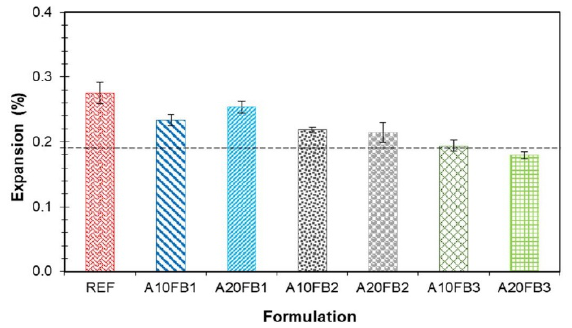
Figure 7. Expansion of mortars containing 10% and 20% of the origin B fines, after 28 days, in NaOH 1N solution.